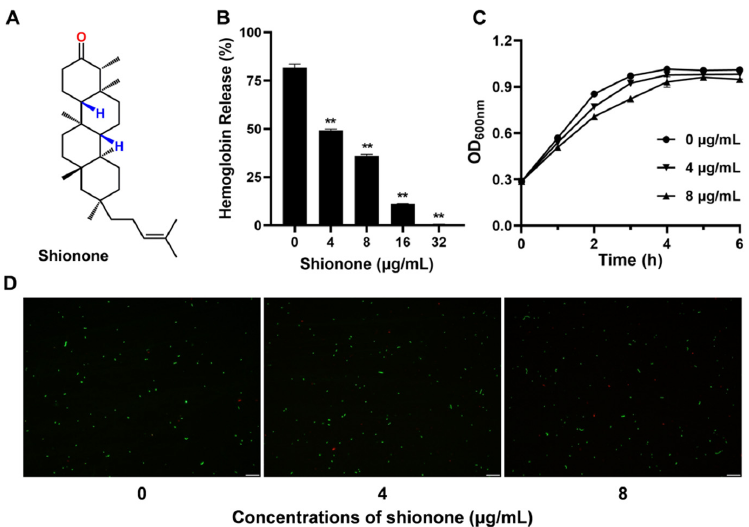
8 µ g/mL, as shown in Figure 2D, because many living cells were dyed green. These results suggested that shionone could alleviate A549 cell injury by neutralizing PLY activity.